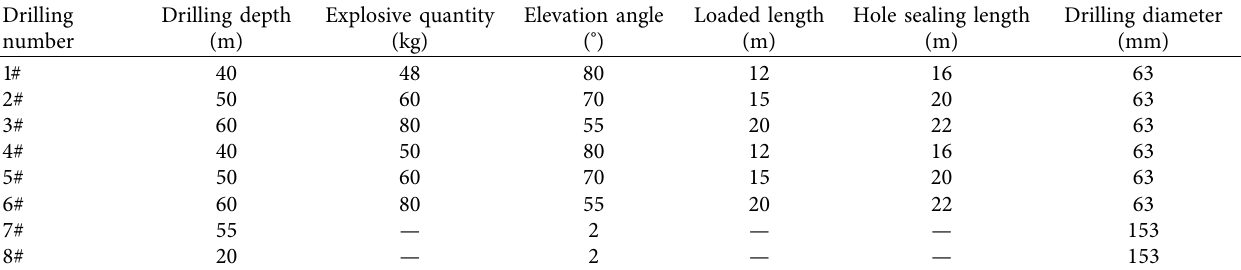
Figure 17: Schematic diagram of pressure relief measures: (a) I-I sections; (b) III-III sections. Table 4: Parameters of pressure relief measures for I-I section.